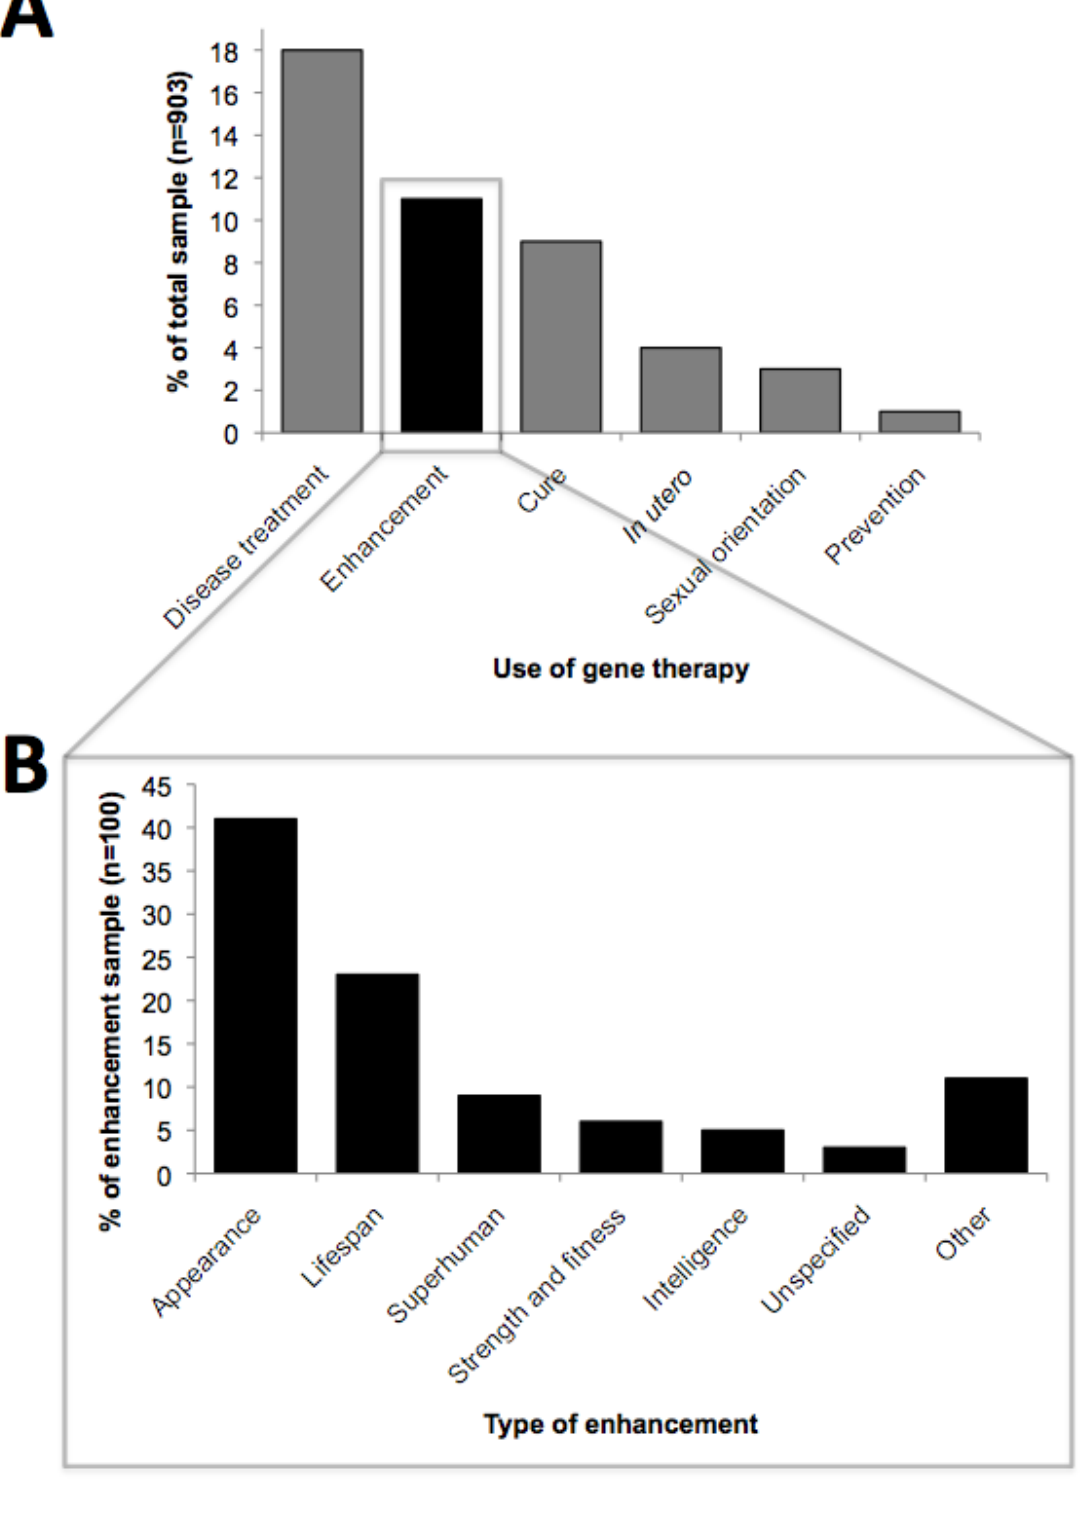
Figure 2. Uses of gene therapy. A) Codes for uses of gene therapy encountered in the question sample. B) Codes for the types of enhancement encountered in the question